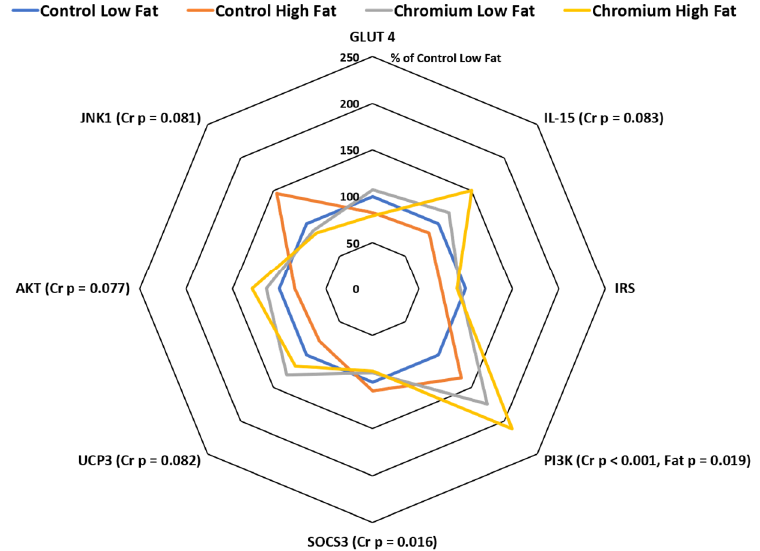
Figure 4. Interleukin-15 (IL-15), insulin receptor (IRS), phosphatidylinositol 3 kinase (PI3K), suppressor of cytokine signaling 3 (SOCS3), uncoupling protein 3 (UCP3), protein kinase B (AKT), mitogen-activated protein kinase-8 (JNK1) and glucose transporter 4 (GLUT4) mRNA expression in skeletal muscle tissue from gilts fed nCrPic with or without a high-fat diet. All gene expression data were analysed as the threshold cycle (cT) relative to that of β -actin (∆CT) and assessed for main and interactive effects of dietary fat and nCrPic by ANOVA. A difference in ∆CT of −1.0 is associated with a doubling (200%) and +1.0 a halving (50%) of expression and for ease of presentation data are presented as % relative to expression in tissue from gilts fed the control diet without supplemental fat or nCrPic. This method of presentation prevents the presentation of the error term.